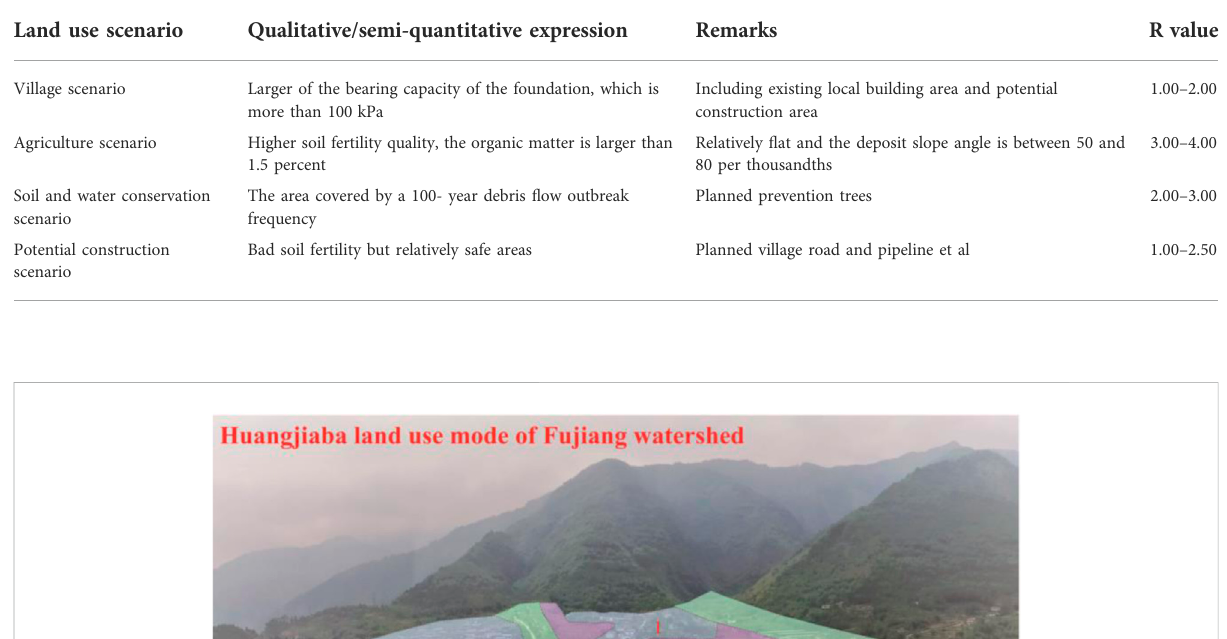
TABLE 7 Debris fl ow land use scenario introduction of Huangjiaba.